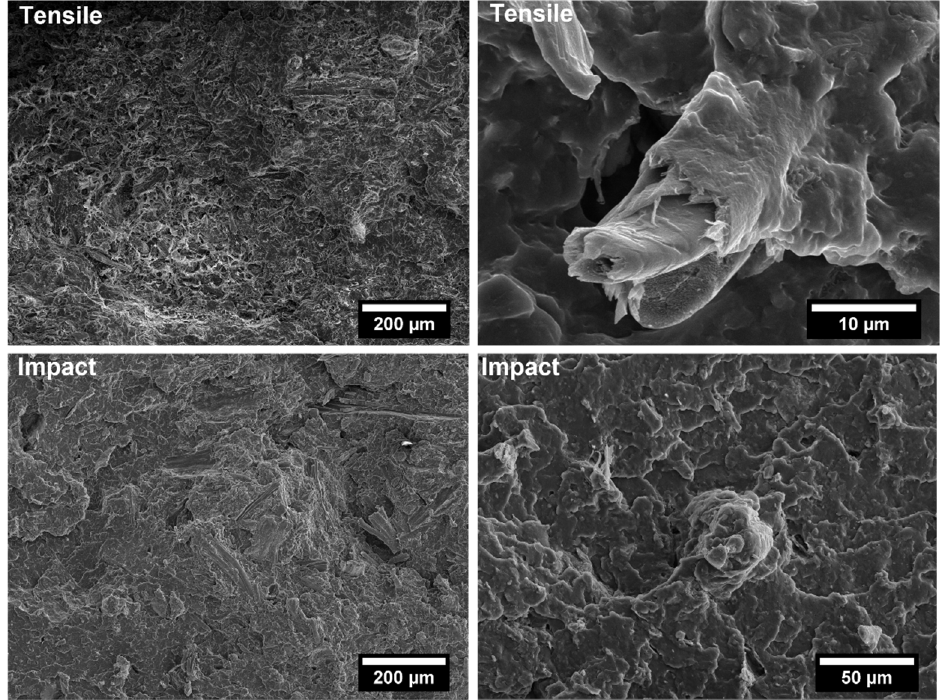
Figure 12. SEM micrographs of PP-based biocomposites with 30 wt.% of licorice root fillers with coupling agent after tensile and Charpy impact tests.